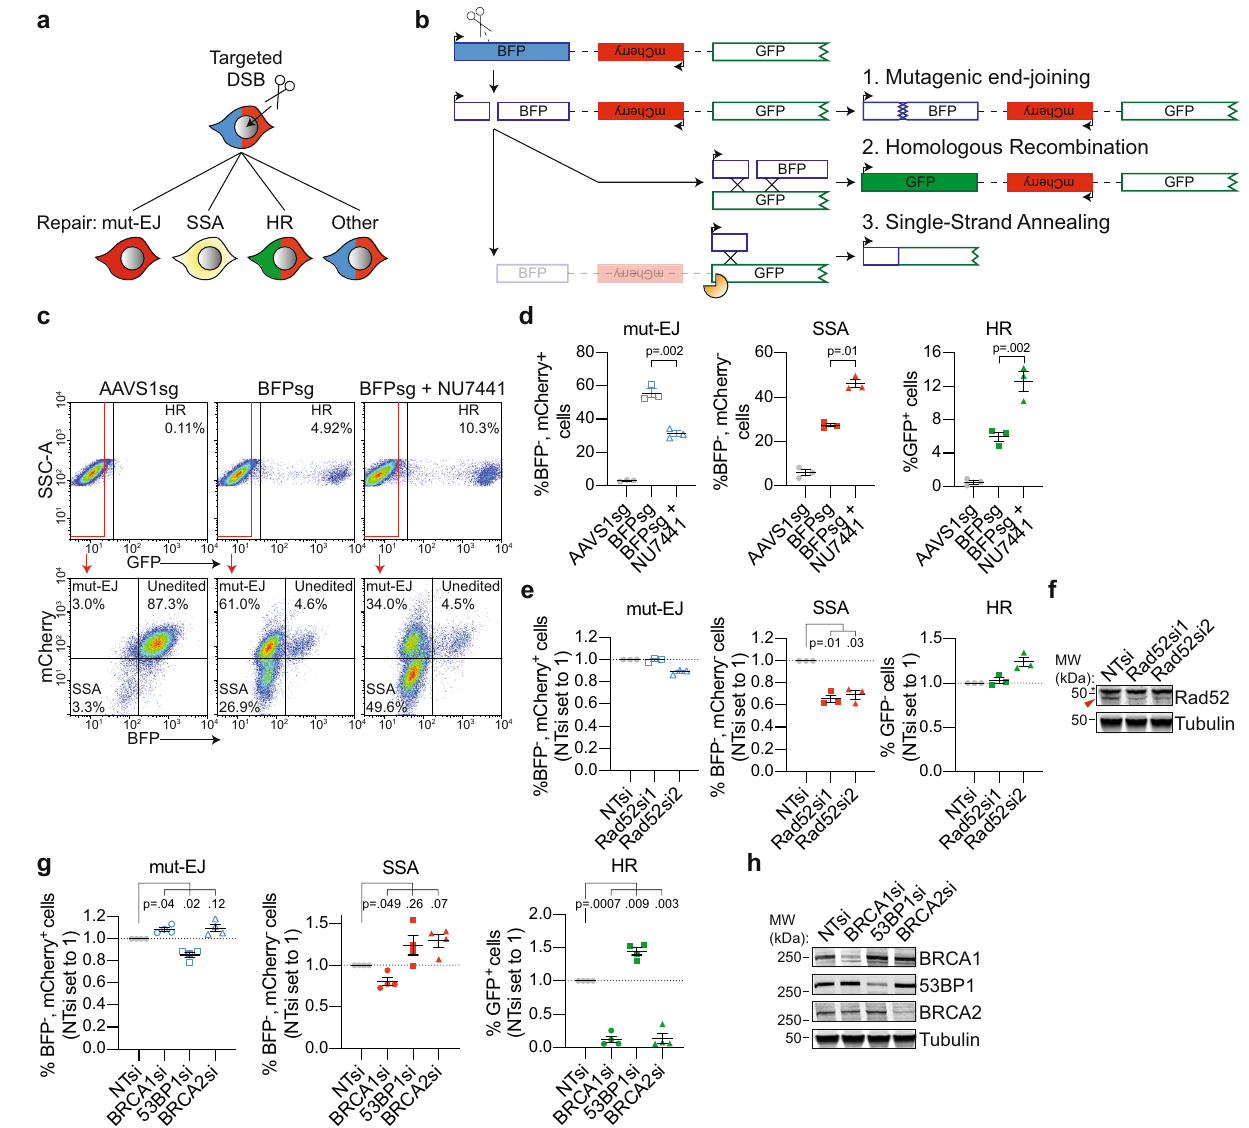
Fig.4|DSB-Spectrum_V3isareporterformutagenicend-joining,SSA,andHR. a Cartoondepictingpotentialoutcomesofamulti-pathwayreportercell-linedesigned toquantifyDSB-repairbymutagenicend-joining(mut-EJ),SSA,andHR. b Diagramatic representation of the genomic DSB-repair reporter construct DSB-Spectrum_V3. ScissorsindicatetheCas9-targetsite,orangepacmanindicatesendogenousnucleases. c,d DSB-Spectrum_V3cellsweretransfectedwithCas9andansgRNAtargetingeither AAVS1 or BFP, followed by treatment with NU7441 (2 µ M). At 72h after Cas9 trans- fectioncellswereanalyzedby fl owcytometry.Panel c showsrepresentative fl owplots. Panel d shows quanti fi cation of the three repair pathways from multiple experiments